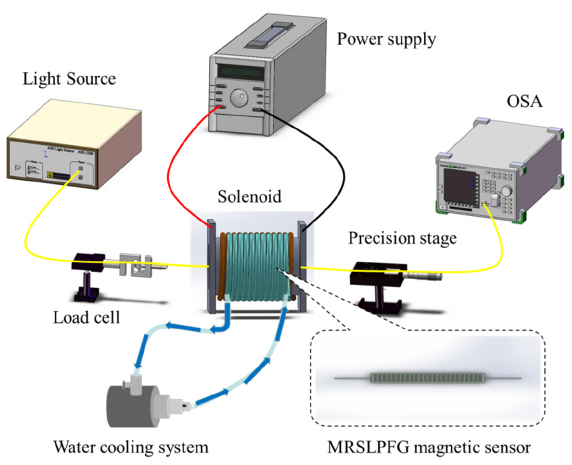
Figure 3. (a) Schematic diagram of the MRSLPFG and in-set diagram detailing the dimensions of the grating structures of the MRSLPFG; (b) The optic microscope (OM) image of the proposed MRSLPFG magnetic sensor.